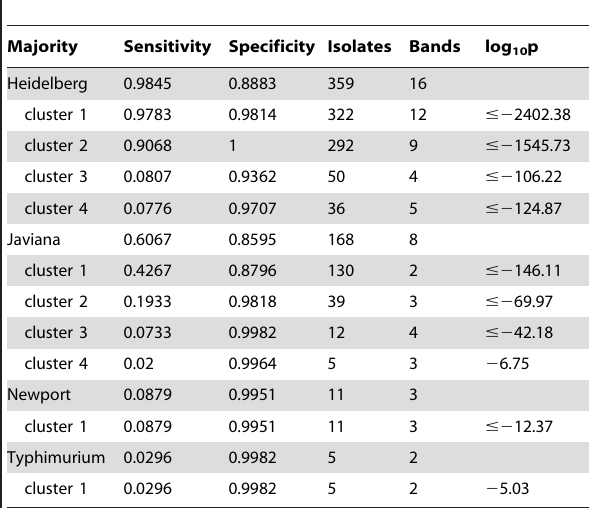
Table 5. The ten largest biclusters out of 14 biclusters identified by SVD(0.2).